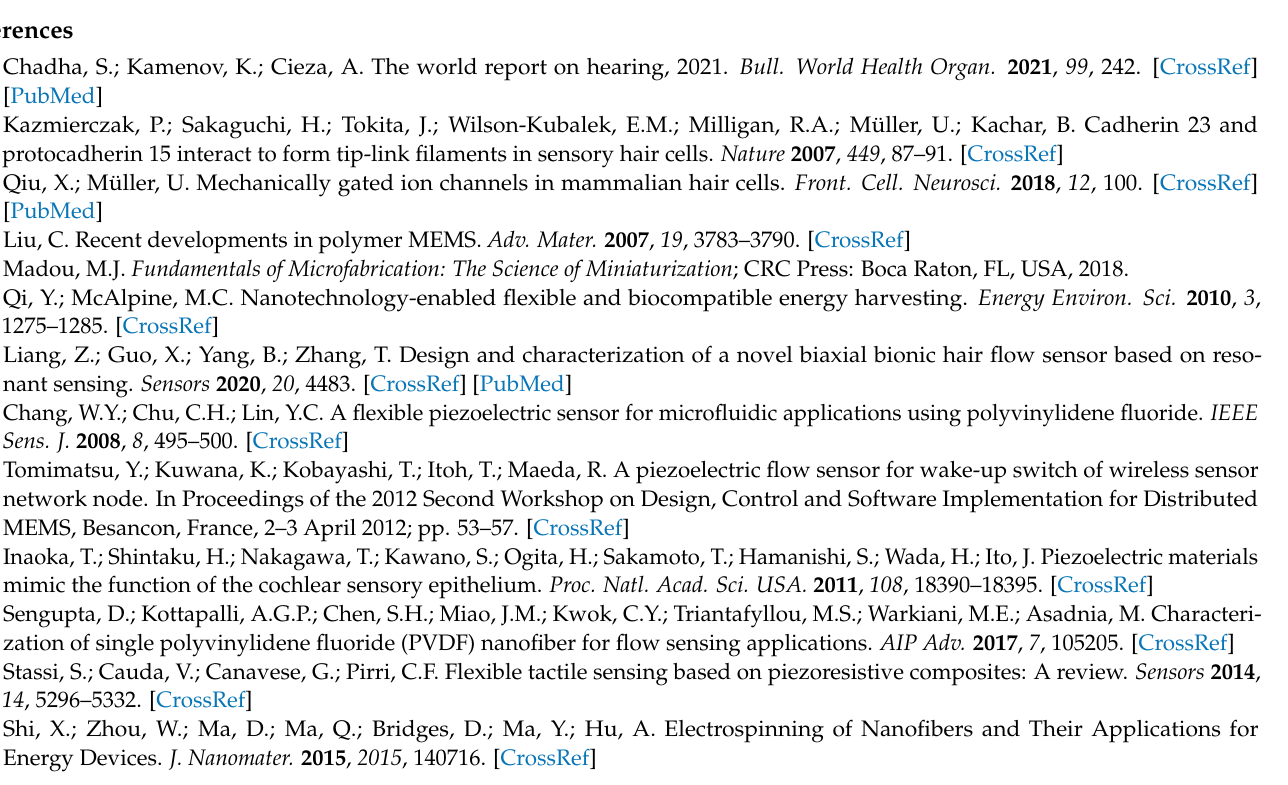
(d) the relation between the mean fiber diameter (nm) vs. collector speed (rpm); Figure S6: The schematic of materials order for the triboelectric property of PVDF electrospun samples; Figure S7: Fraction of β -phase in percentage vs. the concentration of PVDF solution. Table S1: The effect of PVDF concentration on the mean diameter of the nanofibers; Table S2: The effect of changing voltage value on the mean nanofiber diameter; Table S3: The effect of changing distance between the needle and the collector value on the mean nanofiber diameter size; Table S4: The effect of changing feeding rate value on the mean nanofiber diameter size; Table S5: The effect of changing collector speed value on the mean nanofiber diameter size; Table S6: The effect of changing concentration of PVDF in the fraction content of β -phase. References [47–52] are cited in the Supplementary